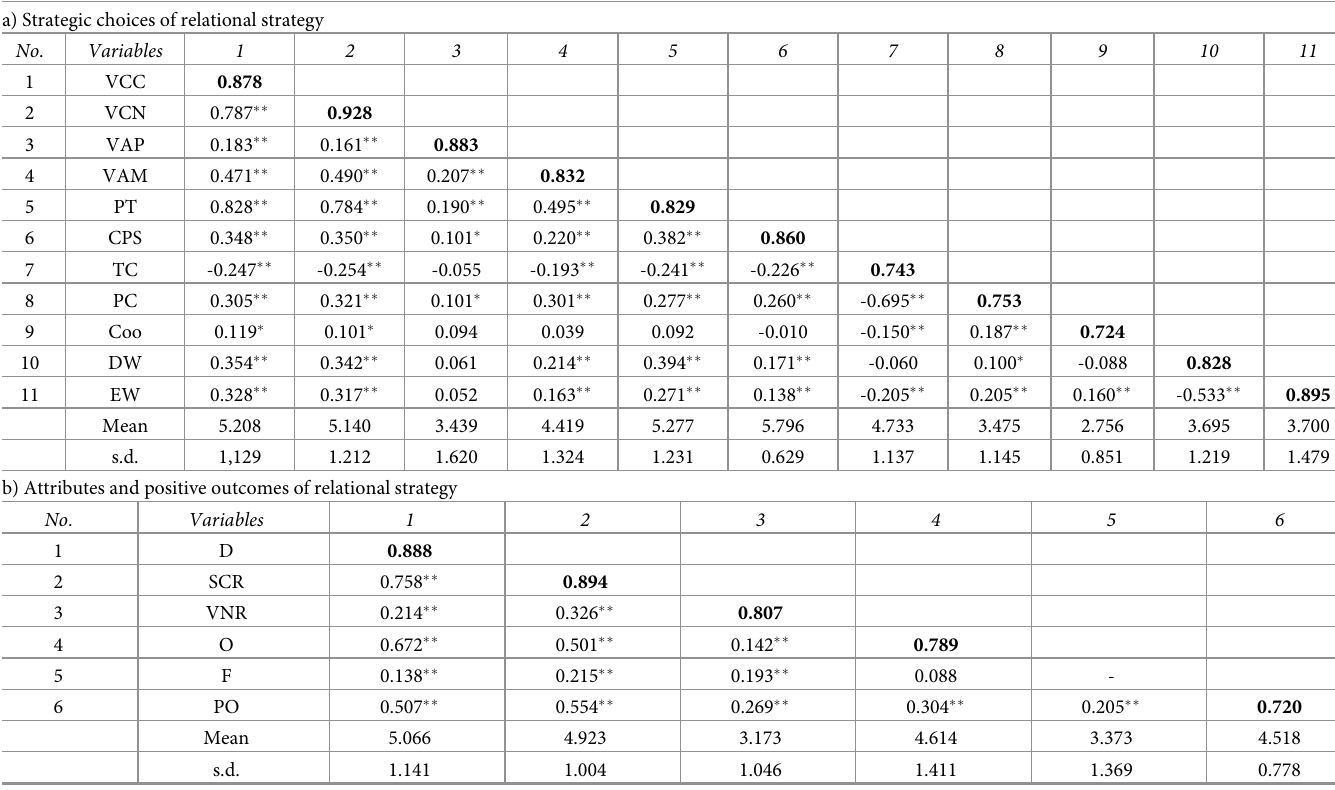
Table 2. Descriptive statistics and correlations between